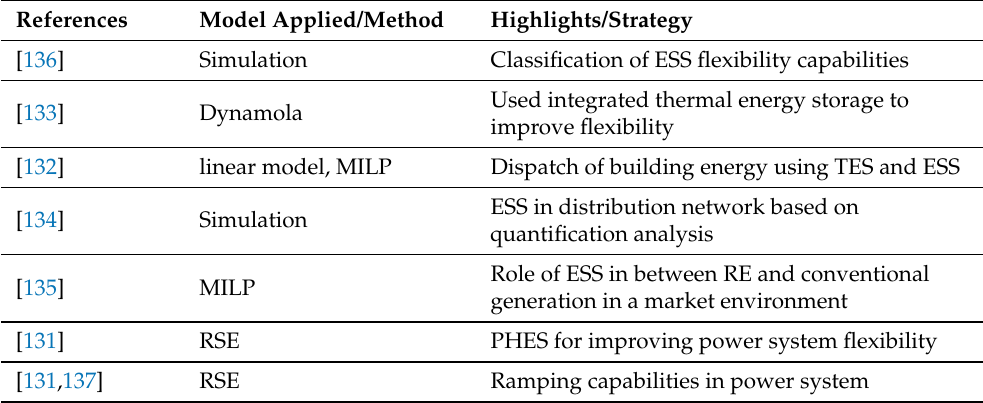
Table 3. Highlights of the flexibility approach based on